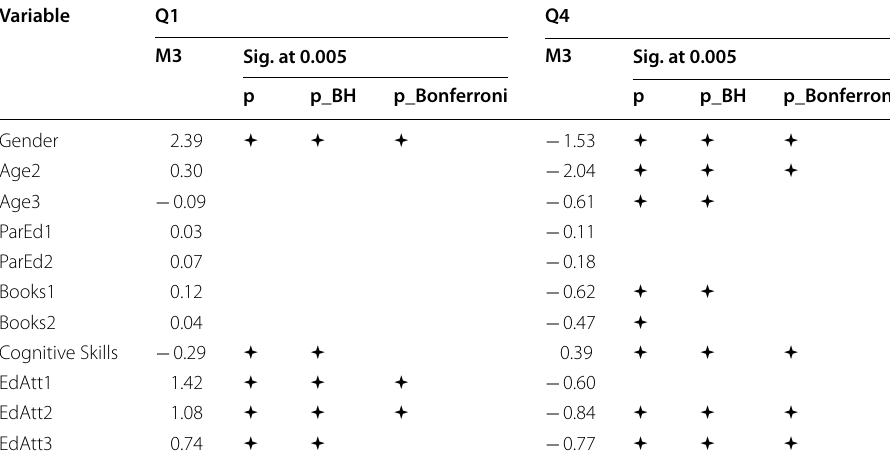
Table 9 Results from M3 [Q1 and Q4]: Japan Variable